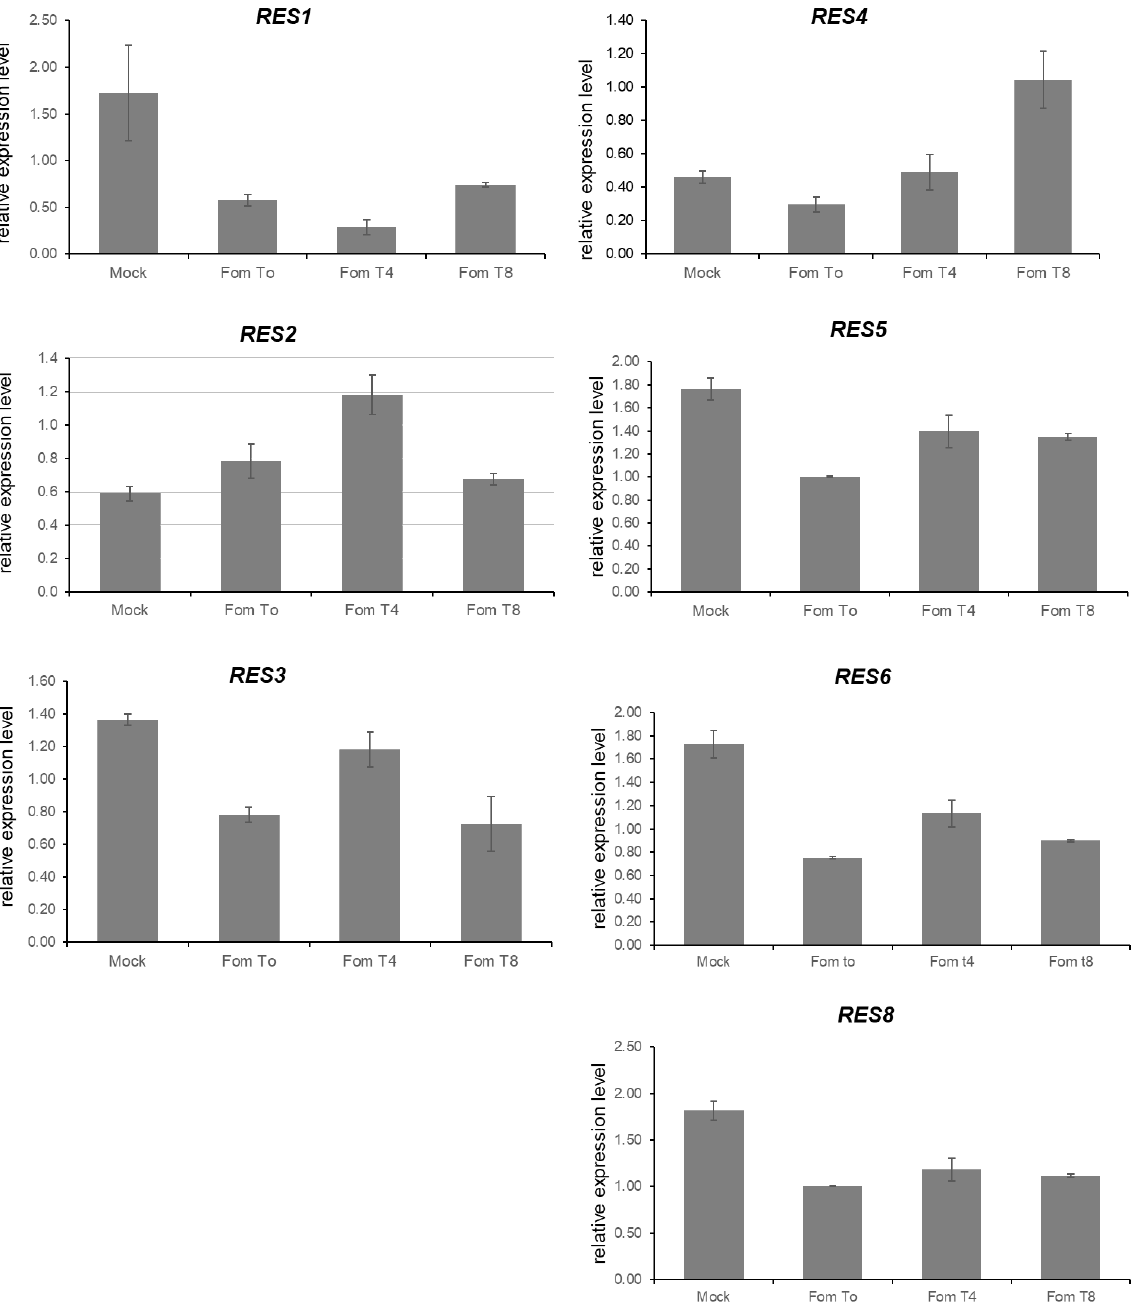
Figure 7. RT-qPCR analysis of S. melongena candidate transcripts using RT-qPCR. Relative quantifi- cation of 7 candidate RES genes. Values are expressed relative to the GAPDH used as a reference gene and are the averages of three biological replicates ( n = 3). Mock control indicates not inoculated samples, Fom t0, t4, t8 indicates inoculated samples at 0-, 4- and 8-h post infection.